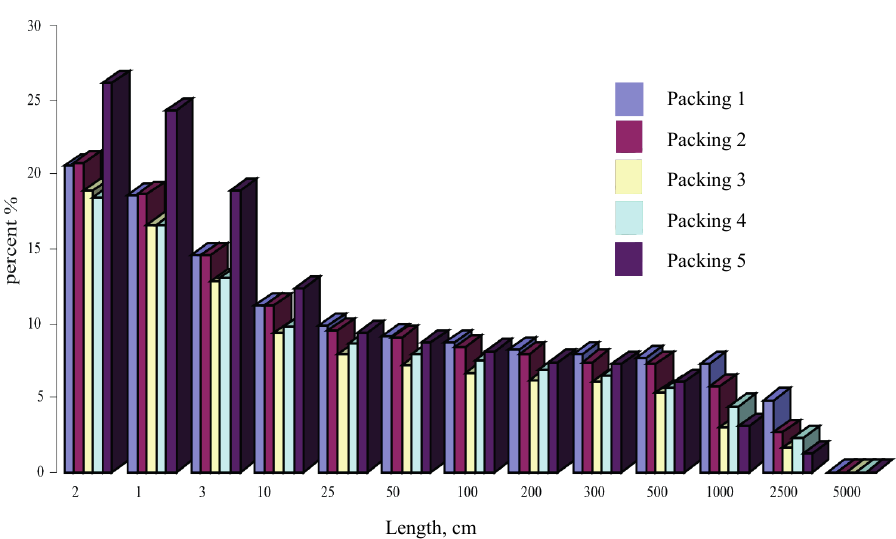
Fig. 6. Spectrum 2. Machine No. 4, material: T-72 tex (No.